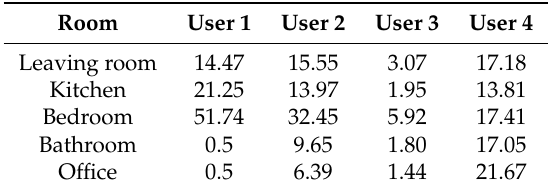
Table 2. Number of hours that each user stay in each